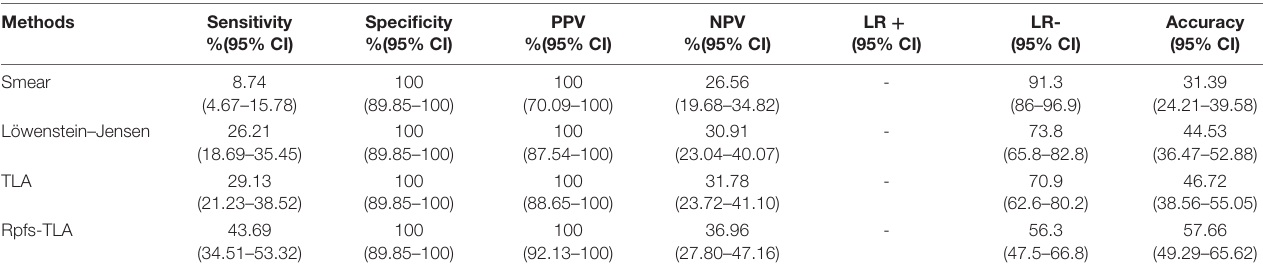
FIGURE 2 | Venn diagram of the overlap among different diagnostics for pleural fluid testing. Rpfs, resuscitation-promoting factors; TLA, thin layer agar; L-J, Löwenstein–Jensen medium; Smear, acid-fast bacilli smear microscopy. TABLE 2 | Diagnostic performance of the smear, Löwenstein–Jensen, thin layer agar (TLA), and resuscitation-promoting factors (Rpfs)-TLA cultures in pleural